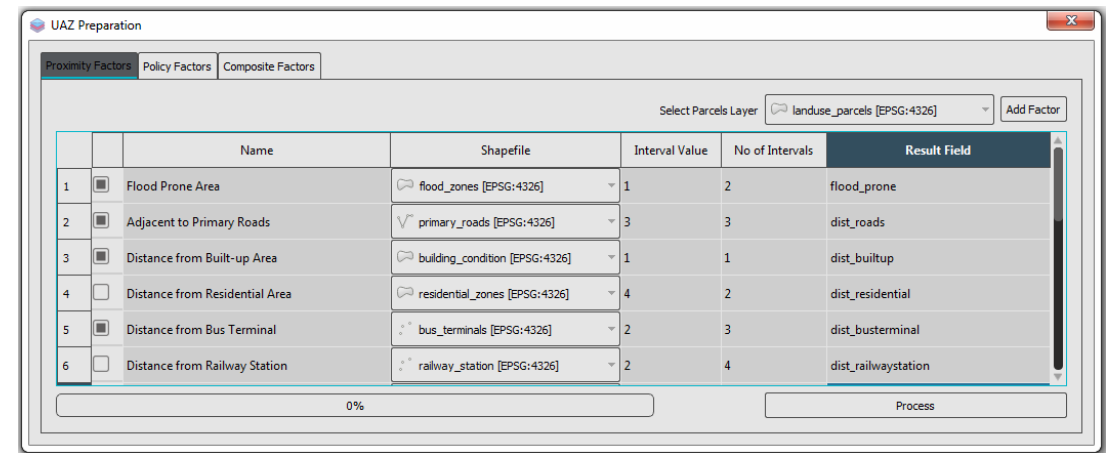
Figure 9. Interface showing the listing of opportunity and constraint factors.